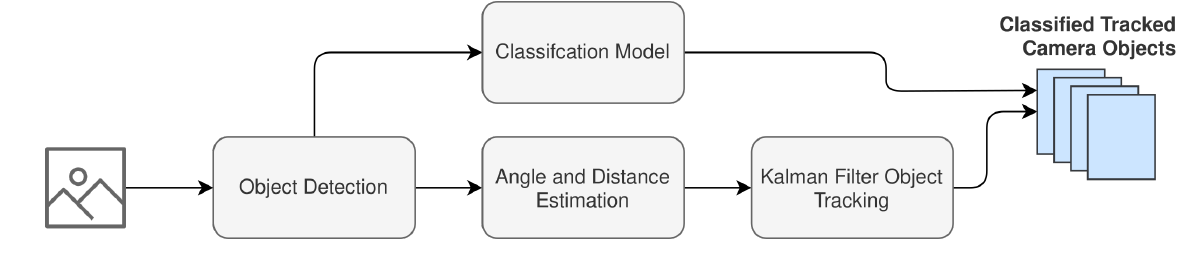
Figure 6. Camera processing pipeline design.